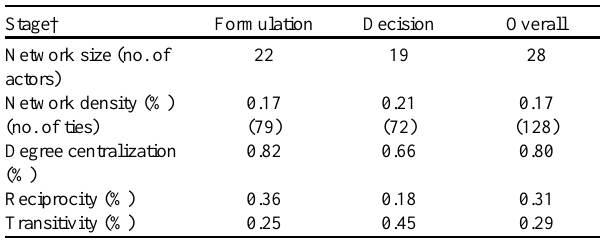
Table 4 . Network cohesion in reform formulation and decision making.